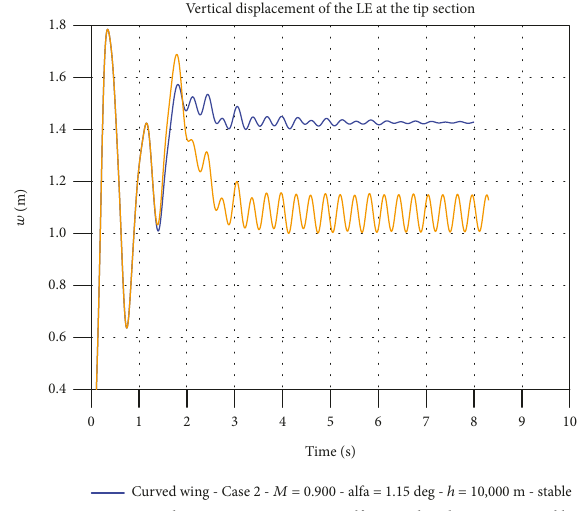
Figure 28: FSI DB — stable histories at the LE of the curved-wing tip (Case 2 [20]).